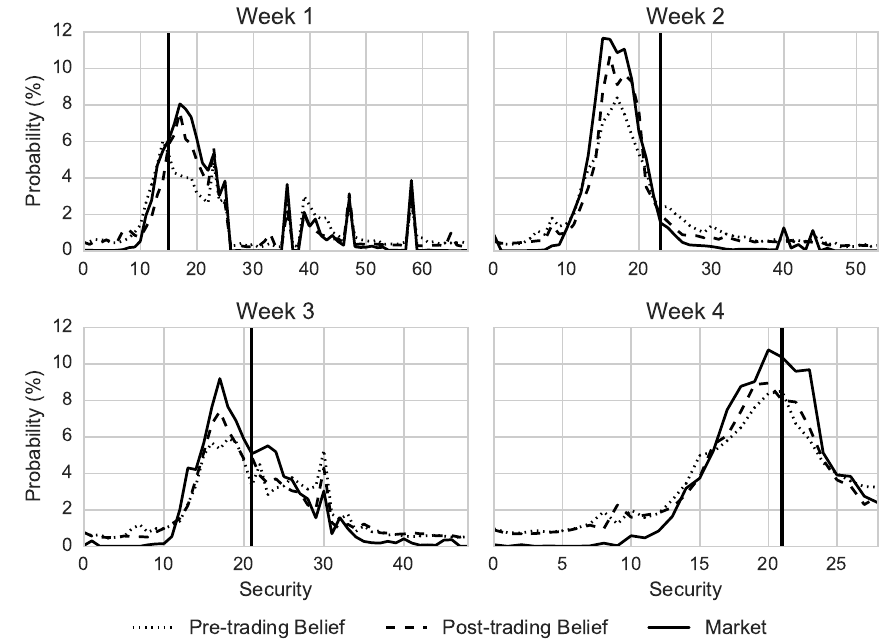
Figure 2: Experiment 2: Average distribution of prices based on the median of all transactions in each epoch and pre-trading and post-trading beliefs averaged across all participants in the market. The price is normalised to ensure that the sum of all security prices is 100. The security whose state was realised at the end of the week (payout of 100 units) is marked with the vertical